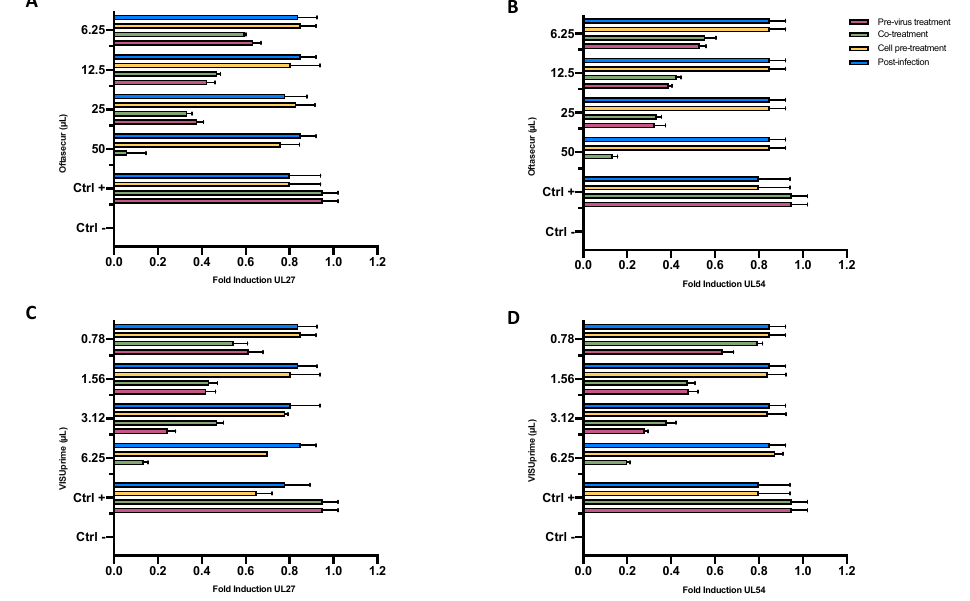
Figure 10. Quantification of mRNA levels of UL27 and UL54 expressed in HSV-1 infected Vero CCL- 81 cells after exposure to Oftasecur ( A , B ) and Visuprime ( C , D ) in different stages of viral infection. Data are presented as the ratio of reference genes (GAPDH) to target genes.